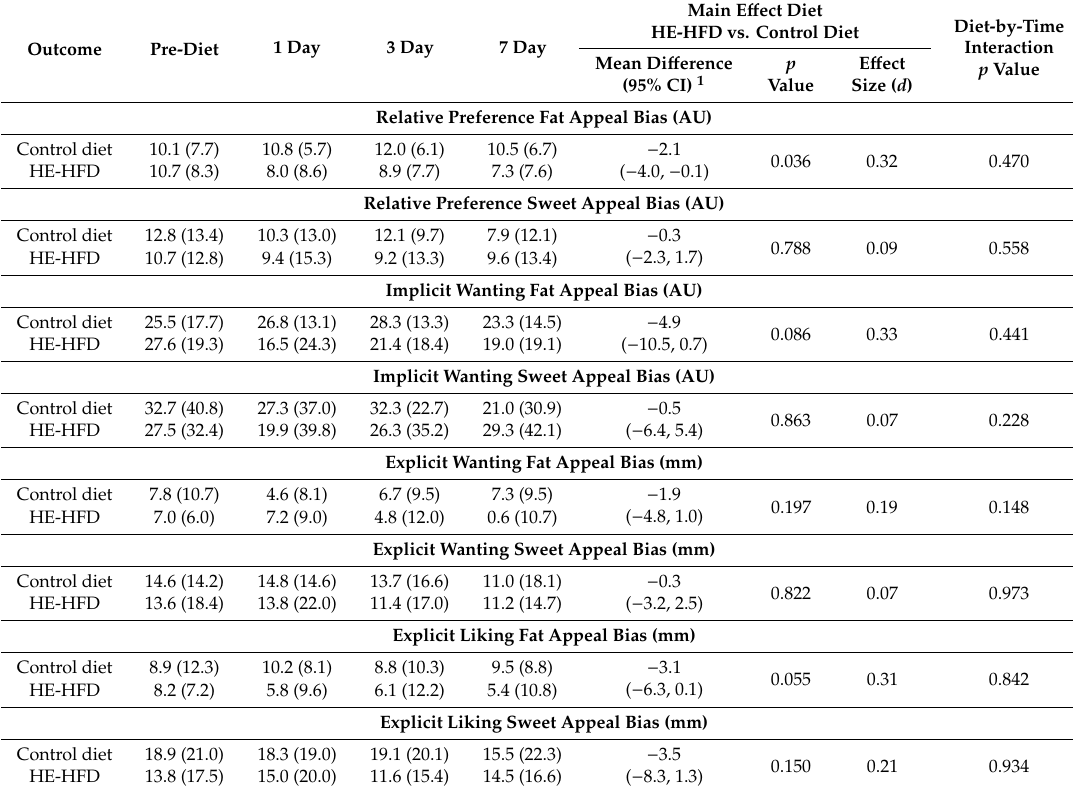
Table 2. Measures of relative preference, implicit wanting, explicit wanting and explicit liking during the seven-day control diet and hyperenergetic high-fat